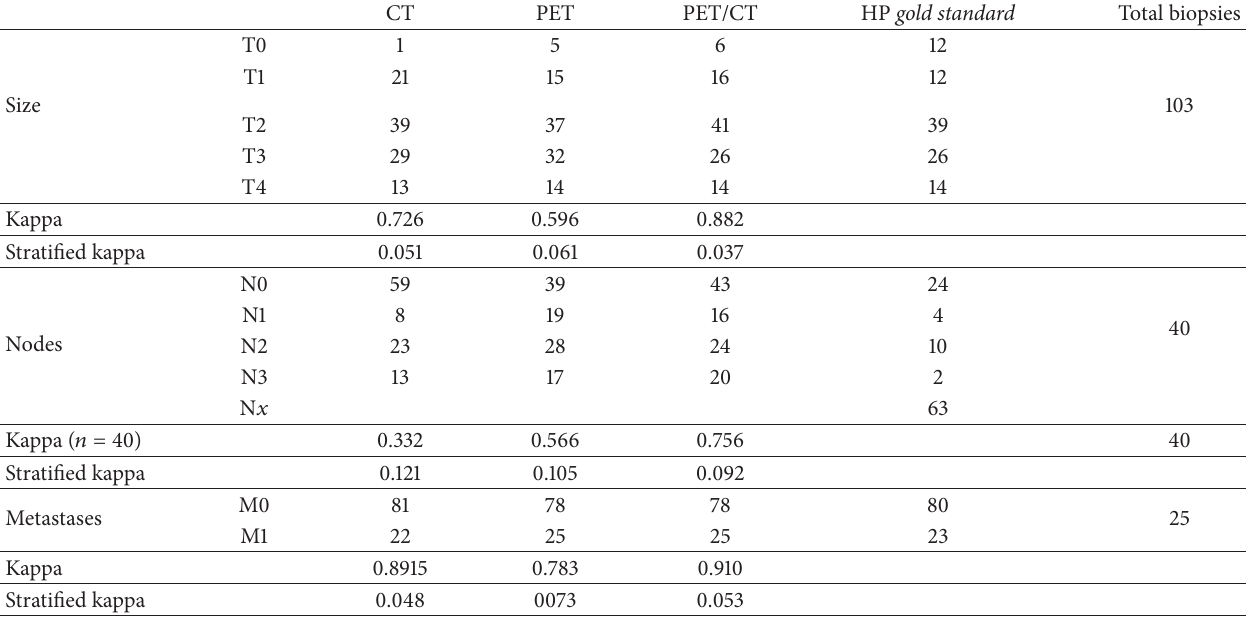
Table 3: Concordance between the three diagnostic techniques and